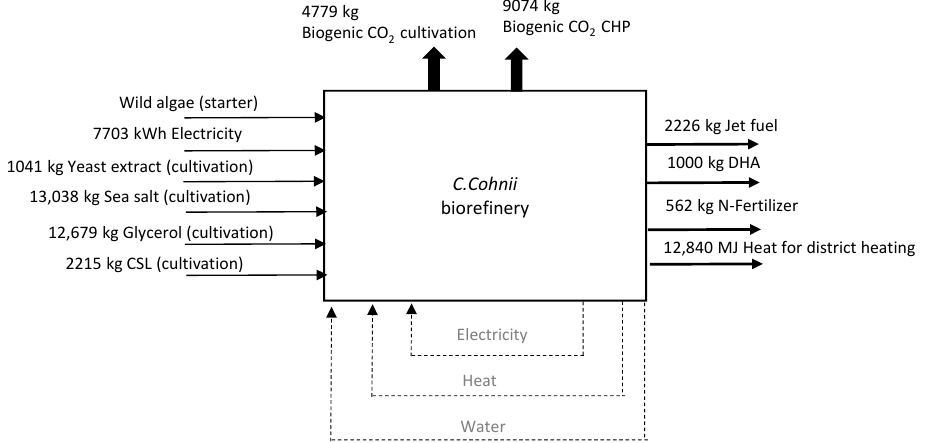
See the Excel file in the Supplementary Materials.